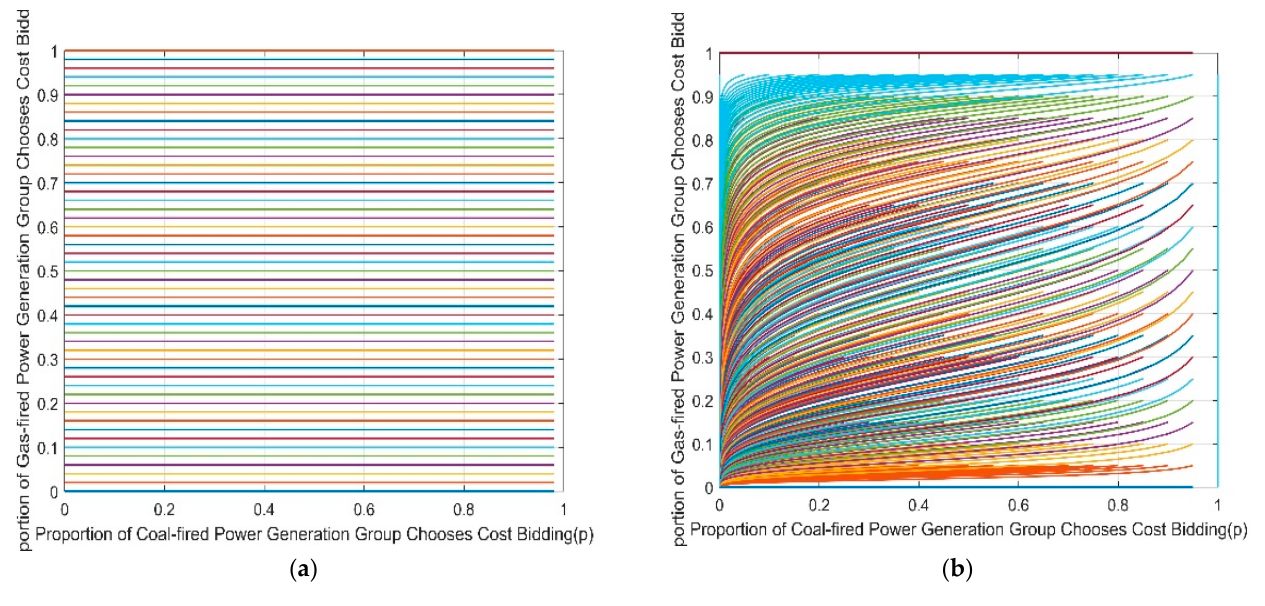
Figure 11. Evolution trend of bidding entities in phases 1 and 4 under scenario 2. ( a ) Simulation results of the evolution of the cost of coal-fired electricity at a much lower cost than gas-fired electricity in February 2021, ( b ) Evolutionary simulation results when the cost of coal-fired electricity is much higher than the cost of gas-fired electricity in January and May 2021.